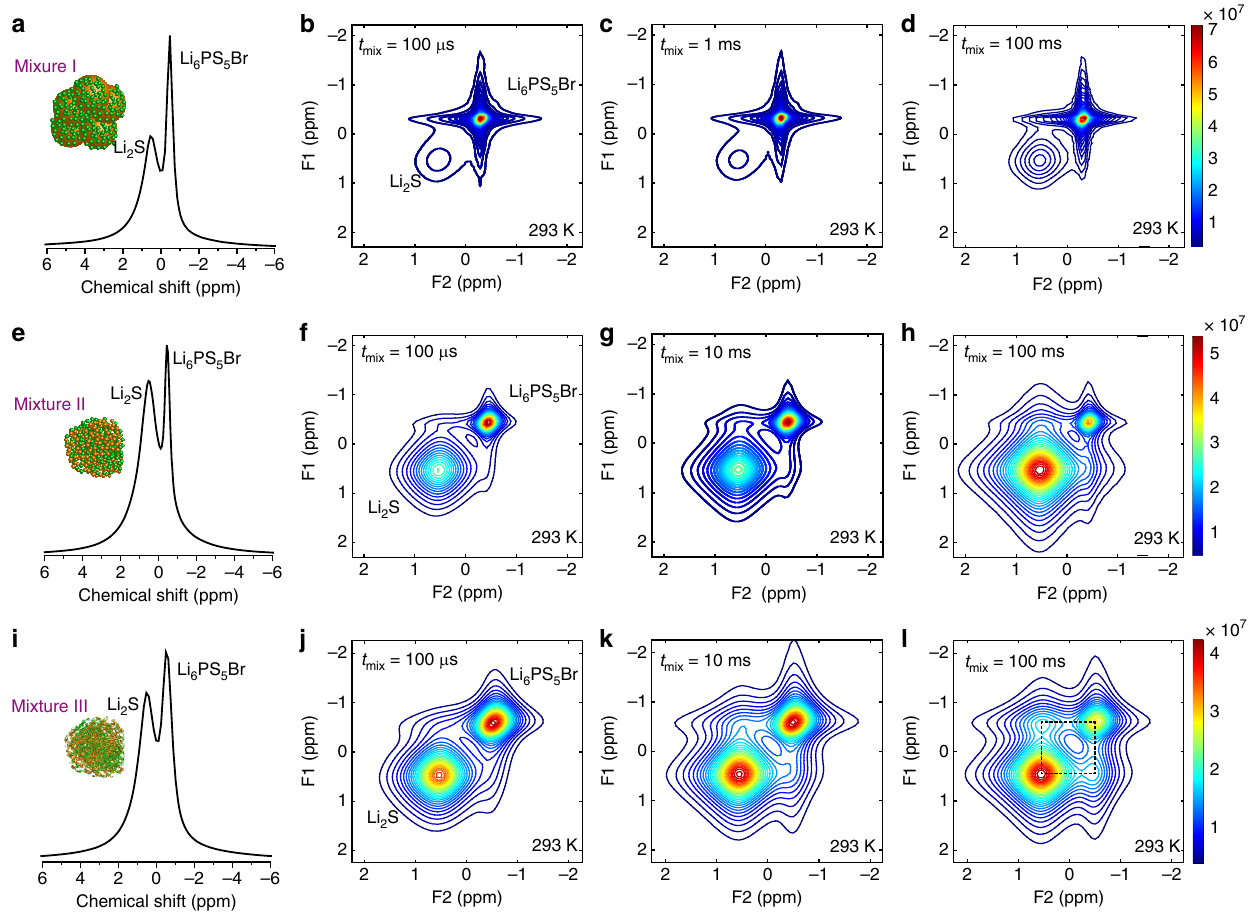
Fig. 2 NMR measuring the spontaneous lithium-ion transport between the Li 6 PS 5 Br solid electrolyte and the Li 2 S cathode. a , e , i One-dimensional (1D) 7 Li magic angle spinning (MAS) spectra corresponding to the Li – Li 6 PS 5 Br 2 S cathode mixtures a mixture I, where Li 2 S is micron-sized e mixture II, where Li 2 S is nanosized i mixture III, where nanosized Li 2 S is thoroughly mixed with Li 6 PS 5 Br. b - d , f - h , j - l Two-dimensional (2D) 7 Li – 7 Li exchange spectra (2D- EXSY) recorded at a 7 Li resonance frequency of 155.506 MHz and a spinning speed of 20 kHz at room temperature for short (100 µ s) to long mixing times t mix (100 ms) for b , c , d mixture I, f , g , h for mixture II, and j , k , l for mixture III. For both mixtures I and II, no obvious off-diagonal cross-peak intensity is observed, indicating that the exchange over the solid – solid Li 6 PS 5 Br – Li 2 S is very small (based on whether an upper limit for the conductivity can be determined as shown in Fig. 4). For mixture III, the off-diagonal cross-peaks appear at t mix = 10 ms, and are most pronounced at t mix = 100 ms, and they correspond to lithium-ion exchange from Li 2 S to Li 6 PS 5 Br and vice versa. Note that the star shape of the 7 Li resonance in Li 6 PS 5 Br is the consequence of the 2D Fourier transform of its Lorentzian shape, a result of the high mobility of lithium ions within the Li 6 PS 5 Br electrolyte – electrode interface in realistic solid-state cathode mixtures. 7 Li magic angle spinning (MAS) NMR spectra of the Li 2 S – Li 6 PS 5 Br mixtures I, II, and III are shown in Fig. 2a, e, i. MAS can average out anisotropic interactions that are described by rank-2 tensors, such as dipolar, fi rst-order quadrupolar and chemical shift anisotropy, provided that the MAS frequency is larger than the interaction width. Compared to Li 6 PS 5 Cl, the fi eld caused by 7 Li NMR resonance for Li 6 PS 5 Br is shifted up increased shielding of the lithium ions by the neighboring Br dopants. This results in a difference in chemical shift between Li in Li 2 S and in Li 6 PS 5 Br, which allows us to distinguish between lithium ions in Li 6 PS 5 Br and Li 2 S phases, making it possible to conduct the 2D exchange NMR experiments. The 2D NMR spectra shown in Fig. 2 show that 7 Li in Li 2 S is represented by a broad homogeneous resonance, whereas 7 Li in Li 6 PS 5 Br is represented by a star-shaped resonance. The latter is the consequence of the large lithium-ion mobility in the Li 6 PS 5 Br solid electrolyte, which results in a Lorentzian line shape that upon 2D Fourier transformation results in the star-shaped NMR resonance observed.